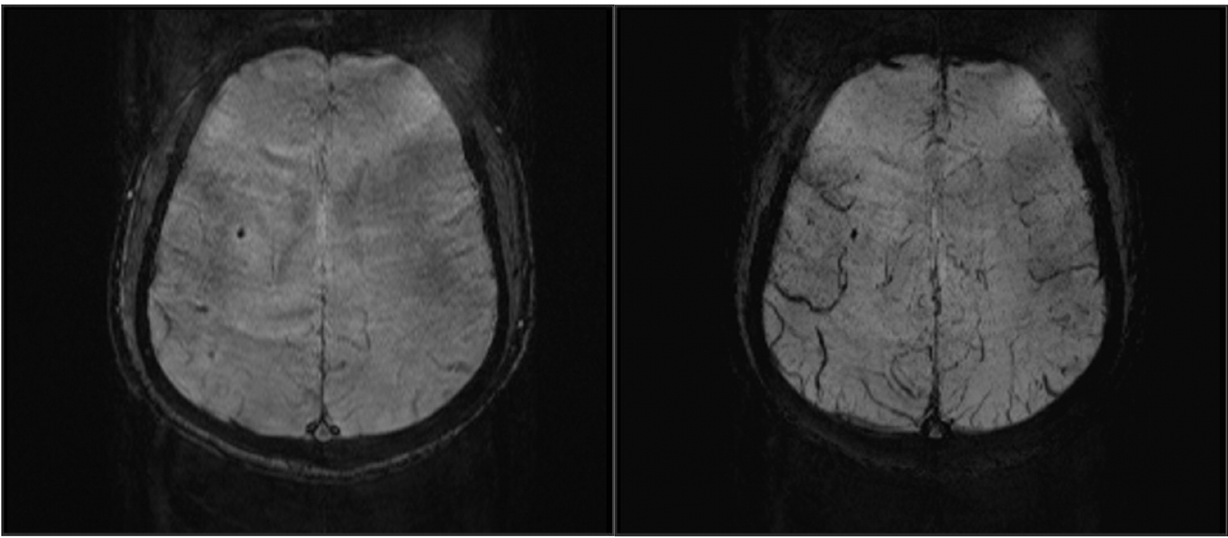
Figure 2. SWI obtained in a 43-year-old man after heat stroke with a score of 3 in Glasgow Coma Scale. On the 4th day after admission, amplitude (A) and minIP (B) images show punctate hemorrhage detected in right corona radiata.